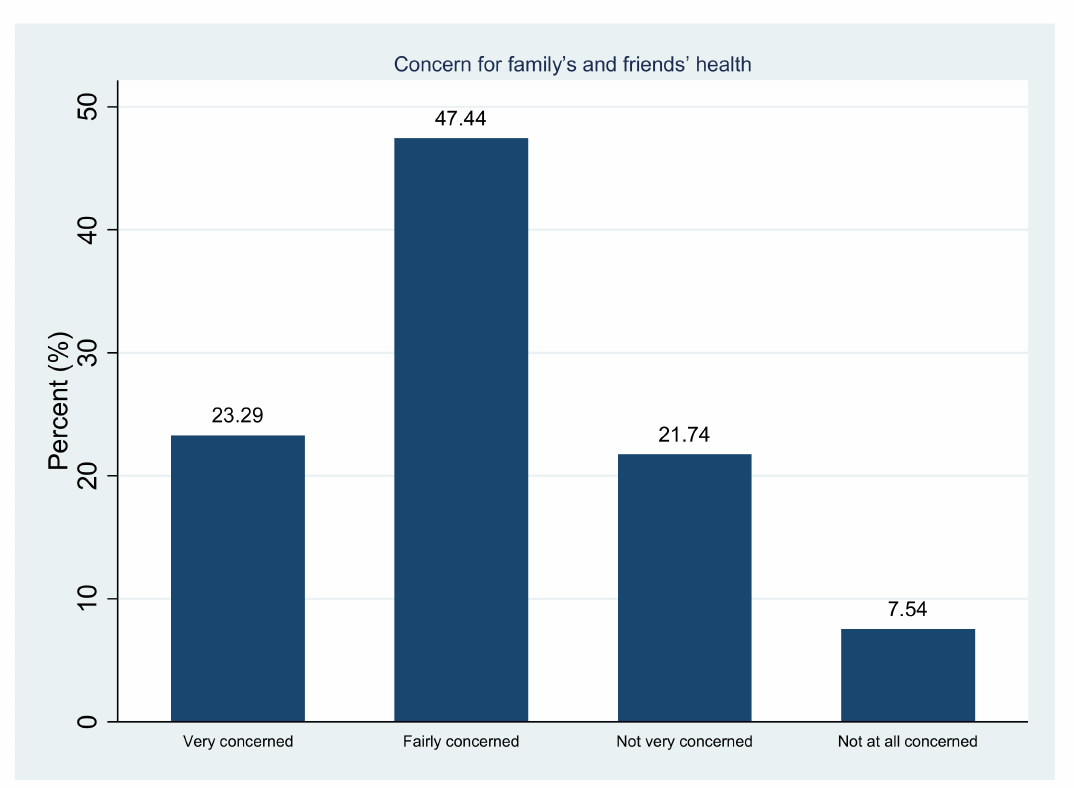
Figure 4. Concern for family’s and friends’ health.